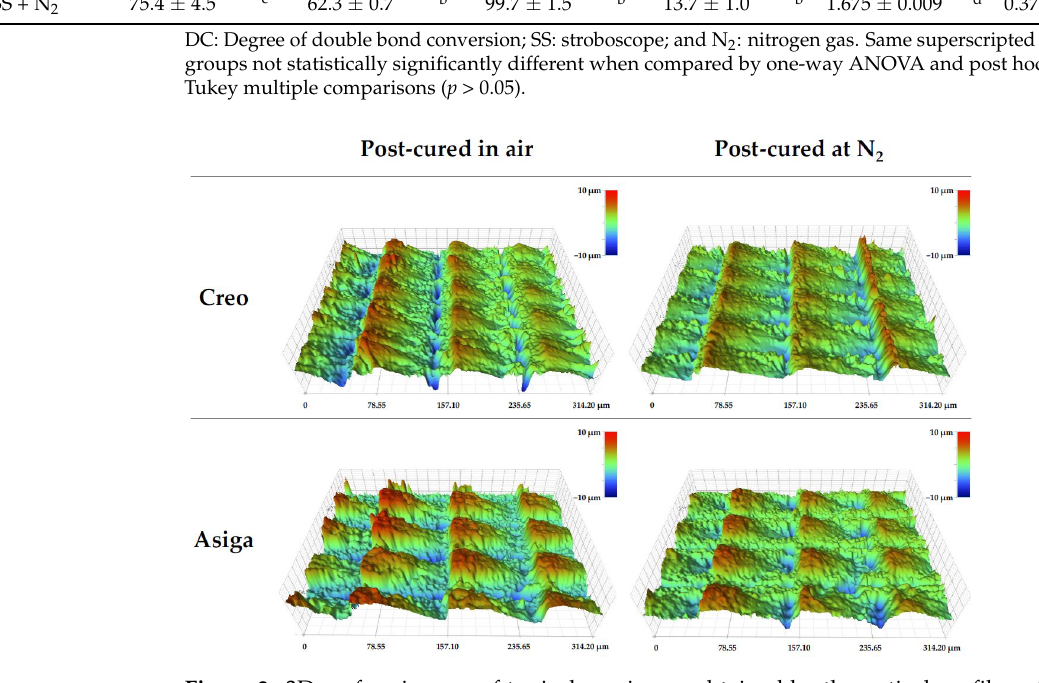
Figure 3. 3D surface images of typical specimens obtained by the optical profilometer. Note the shallower grooves between microstructures in the Creo specimen post-cured at an N 2 atmosphere compared to other specimens.